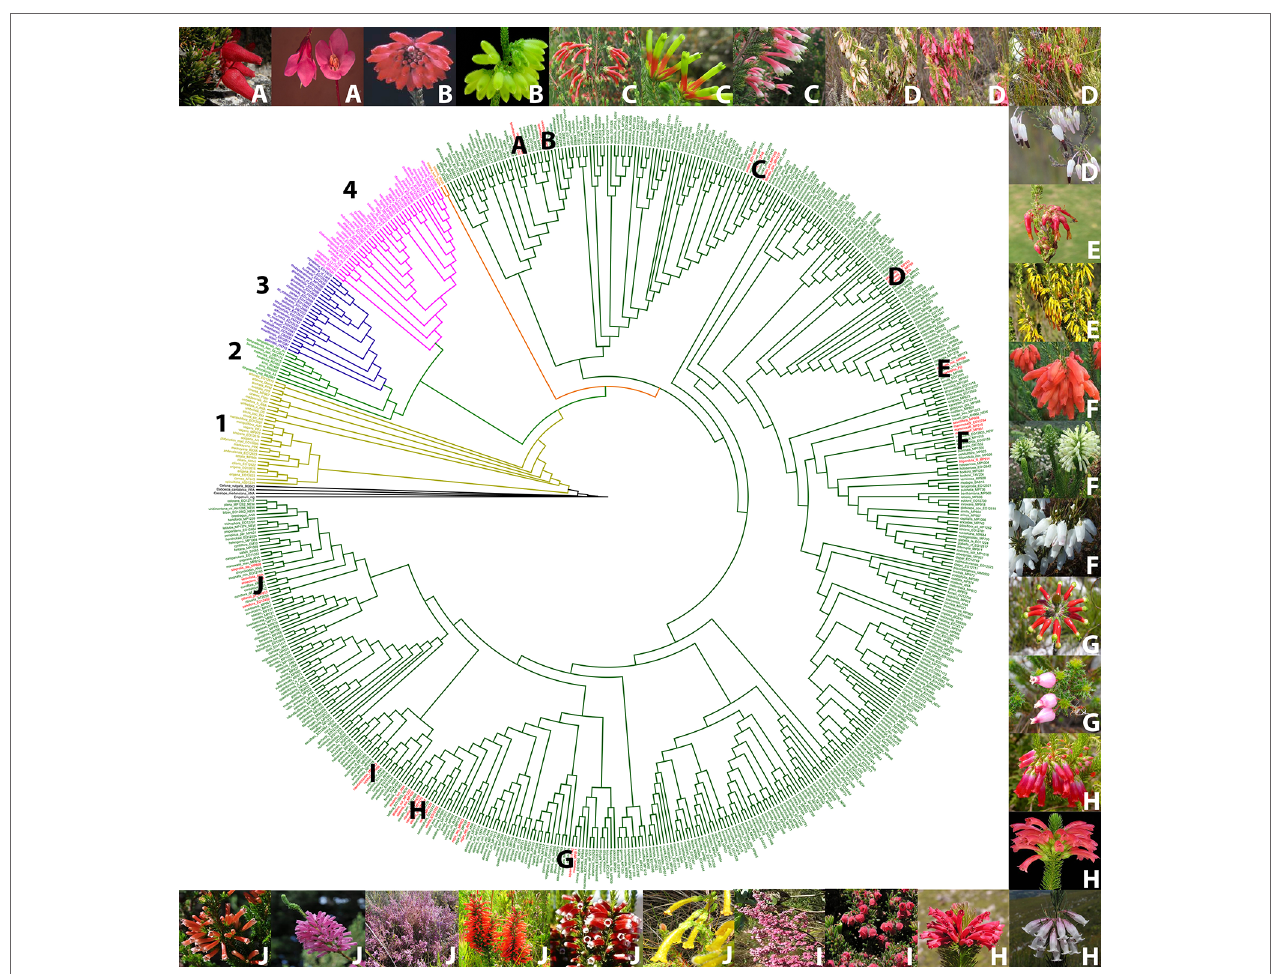
FIGURE 2 | Phylogenetic tree of the genus Erica , with the major clades indicated with numbers, and the pink/red/white/yellow flowered species groups we investigated in the Cape clade indicated with letters (Le Maitre, 2017; Pirie et al., 2011, 2016). Outgroup species (black), 1. European clade (yellow), 2. African clade (light green), 3. Indian Ocean islands clade (purple), 4. Drakensberg clade (pink), E. trimera sister group to Cape Clade (orange) and Cape Clade (dark green). Red flowered species (red). (A) E. cameronii and E. tetrathecoides (B) E. cerinthoides and E. sparrmannii (C) E. discolor ssp. speciosa, E. unicolor ssp. unicolor and E. prolata (D) Erica plukenetii spp. plukenetii and E. plukenetii ssp. breviflora, (E) E. monadelphia and E. coccinea ssp. coccinea (F) E. mammosa, E. sessiliflora and E. filipendula ssp. filipendula (G) E. massonii and E. squarrosa (h) E. regia ssp. regia, E. abietina ssp. abietina, E. viscaria spp. longifolia and E. vestita (I) E. haematocodon and E. hirtiflora (J) E. stagnalis ssp. stagnalis, E. leucotrachela, E. pillansii, E. parviflora, E. verticillata and E. annectans. Images of species are in the same order, clockwise from top left. Photo credits: South African National Biodiversity Institute, casabio.org ( E. tetrathecoides and E. massonii © G Kirsten, E. filipendula ssp. filipendula © Cameron McMaster) and iNaturalist ( E. squarrosa © Hayley-May Wittridge, E. pillansii and E. stagnalis ssp. stagnalis © Linkie).